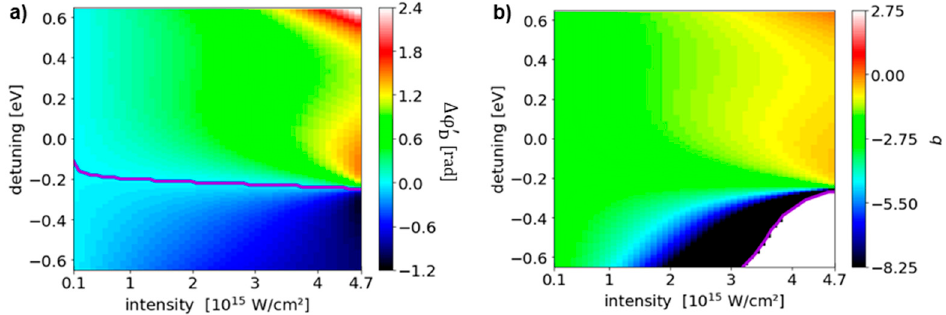
Figure 4. ( a ) dipole phase shift ∆ ϕ (cid:48) and ( b ) q parameter of the autoionizing 2s2p resonance in helium under variation of the driving pulse peak intensity and detuning. The dipole phase shift of the autoionizing resonance is comparable to the case of the two-level system, but an asymmetry along the detuning axis arises from the weak-field asymmetric Fano absorption profile. More details are given in the text. In ( a ), the superimposed violet line indicates an unchanged dipole phase, ∆ ϕ (cid:48) (cid:3406) 0 rad , whereas in ( b ), the jump around q → ± ∞ , corresponding to a Lorentzian profile, is also marked violet in the parameter region I 0 = ( 3 ... 4.7 ) × 10 15 W/cm 2 and ∆ = ( − 0.65 ... − 0.2 ) eV.